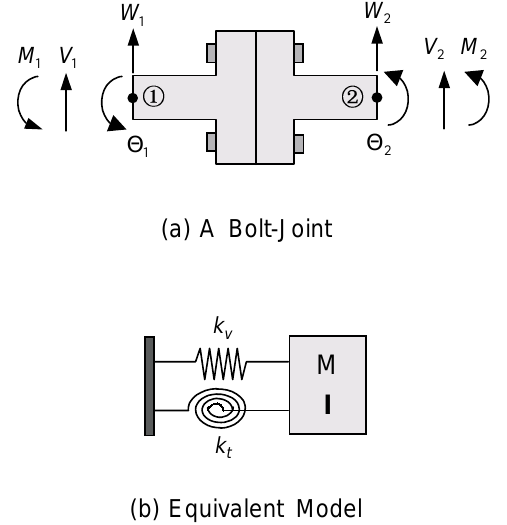
Fig. 3. Equivalent bolt-jont model with four parameters.